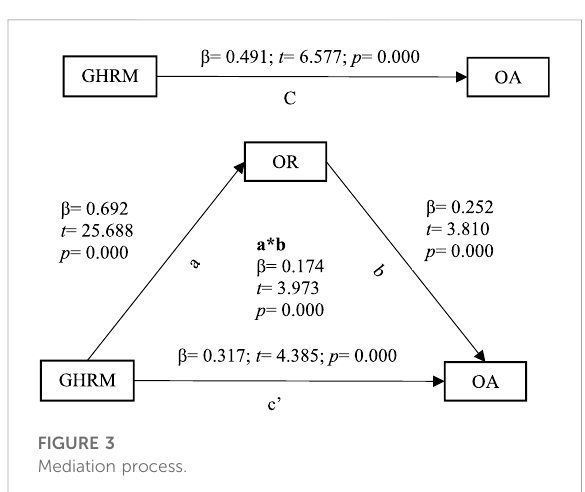
FIGURE 3 Mediation